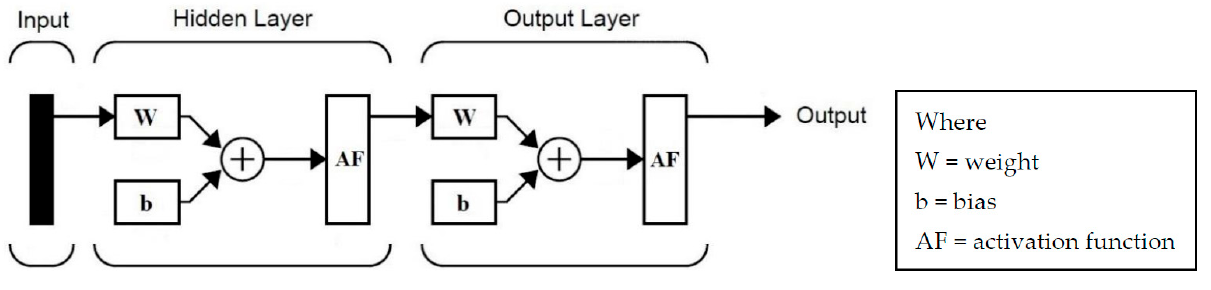
Figure 2. Vanilla FFBPNN architecture.